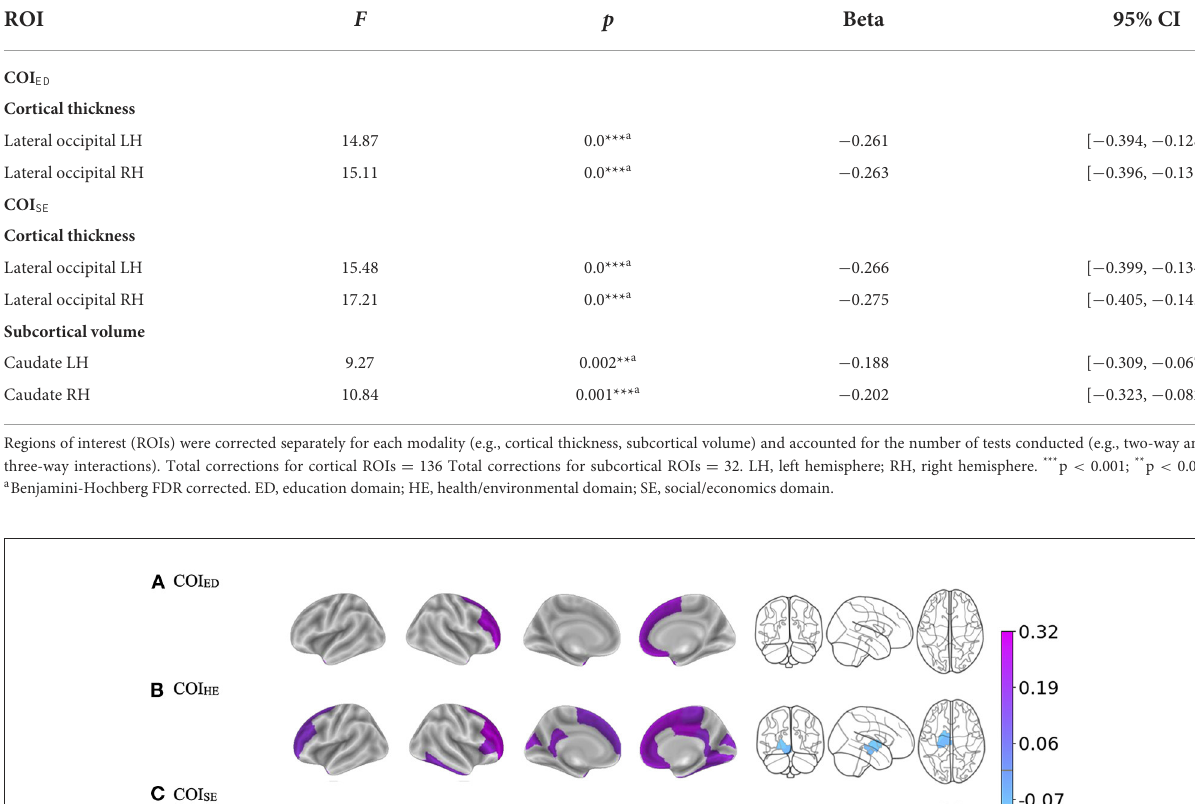
youth with medium and higher levels of COI SE . Subcortically, youth with access to fewer COI SE resources had larger left hemisphere subcortical volumes of the caudate, pallidum, and ventral DC. Figure 5C shows visual representations of these interactions for the two largest effects of which were 1 cortical (e.g., right rostral middle frontal) and 1 subcortical region (right pallidum). These effects were independent of Youth sex, Youth race, Youth ethnicity, puberty, income-to-needs, time (e.g., baseline, 2-year follow-up), and the child’s access to COI HE and COI ED resources in the